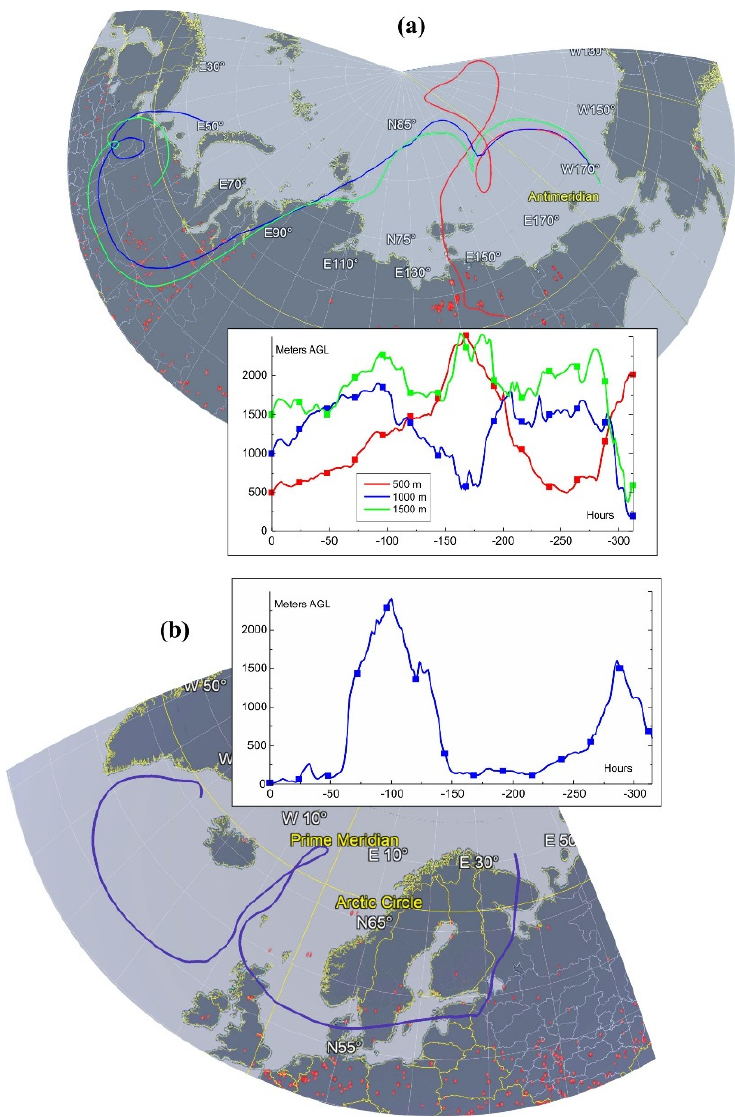
Figure 9. Back trajectories and heights above ground level (AGL) of air mass motion to the regions of measurements and fire centers: ( a ) on 17 August in the Chukchi Sea; ( b ) on 6 September toward the south of the Barents Sea (near Murmansk) to the height of 20 m.